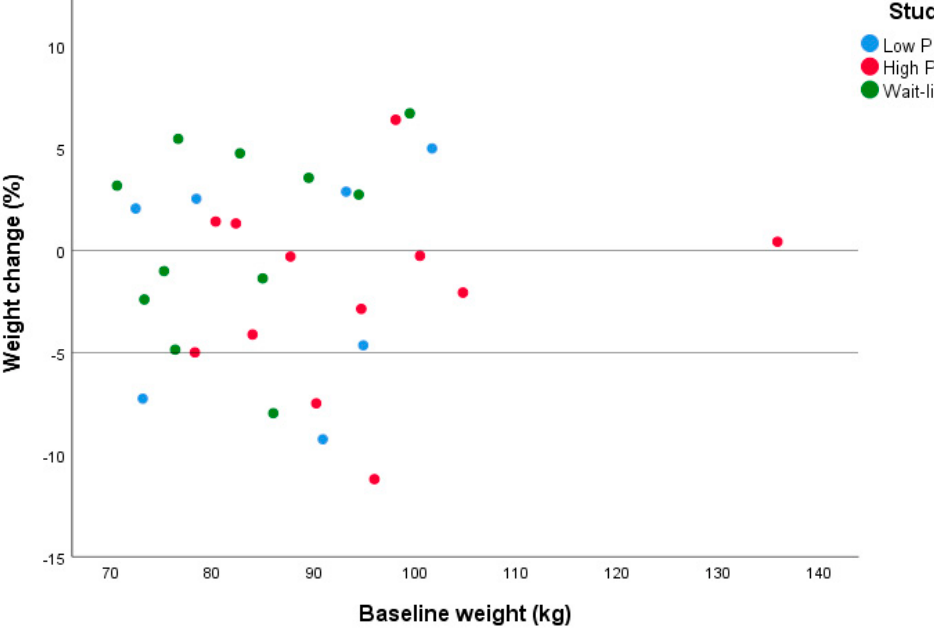
Figure 3. Individual weight change (% of baseline weight) at 6 months by group in a pilot randomised controlled trial for women with recent gestational diabetes who were at risk of developing type 2 diabetes